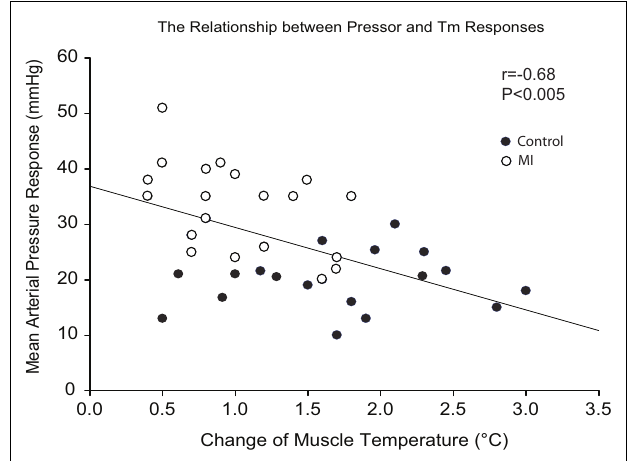
FIGURE 3 | Regression analyses between MAP response and muscle temperature change during static contraction at baseline T m of 30 and 34˚C. Note that a higher MAP response was seen as a lower T m was induced by muscle contraction.